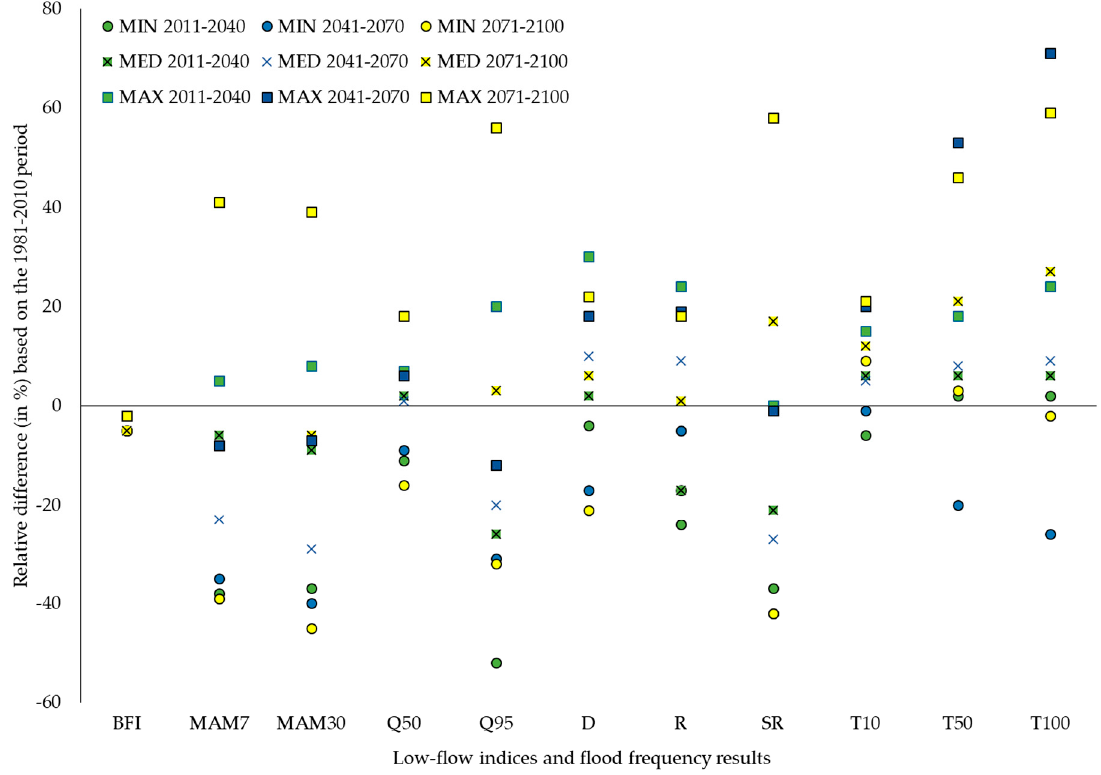
Figure 7. Low-flow indices and flood frequency results (T10, T50, T100 are discharge with a 10, 50, and 100-year return period, respectively) for the periods of 2011–2040, 2041–2070, and 2071–2100 for the Mali otok gauging station (Nanoš č ica River). All values are given as a relative difference (in %) based on the 1981–2010 period. Five climate models (RCP4.5 scenario was used) were investigated and the minimum, median, and maximum values of these five models are shown. Different colors represent different 30-year periods and different symbols (i.e., circle, cross, and rectangle) represent the minimum, mean, and maximum values.